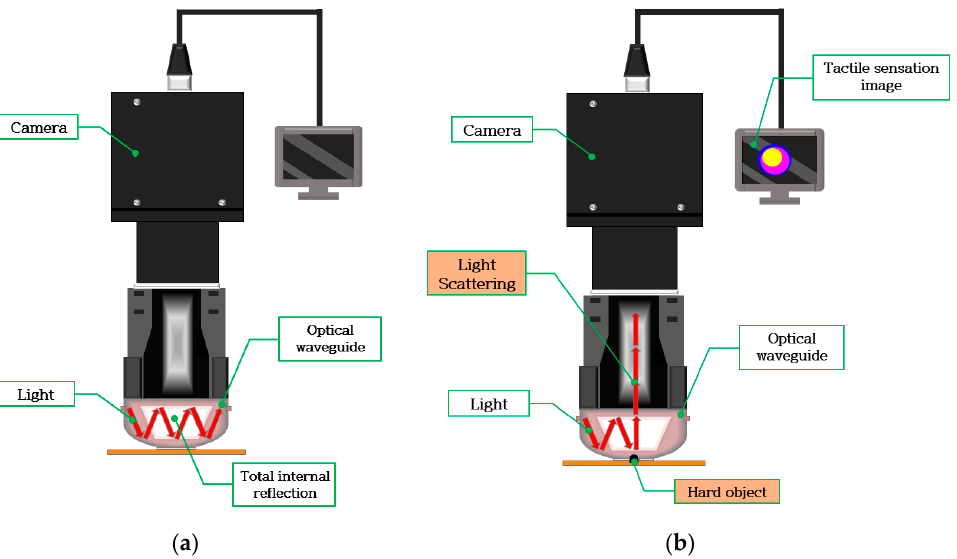
Figure 6. Conceptual diagram of the imaging principle. ( a ) Light is injected into the waveguide and fully reflected. ( b ) Light is scattered as the waveguide is deformed by an external force caused by a hard object.